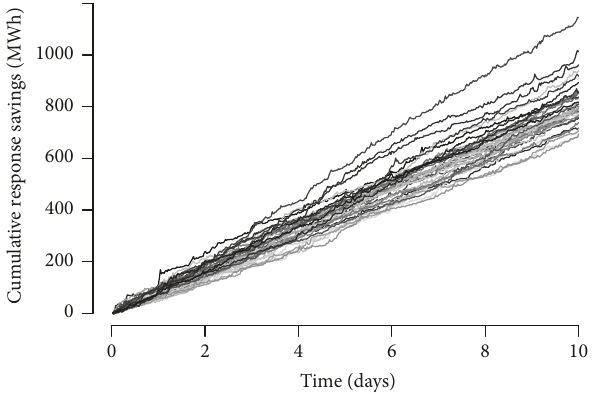
Figure 14: Cumulative response savings (MWh) (see Figure 13) for a heterogeneous fridge population with 𝑃 𝑐 = 700 MW. The introduction of a very small amount of diversity has eradicated the detrimental behaviour in all cases and the fridge population provides a clear benefit to the